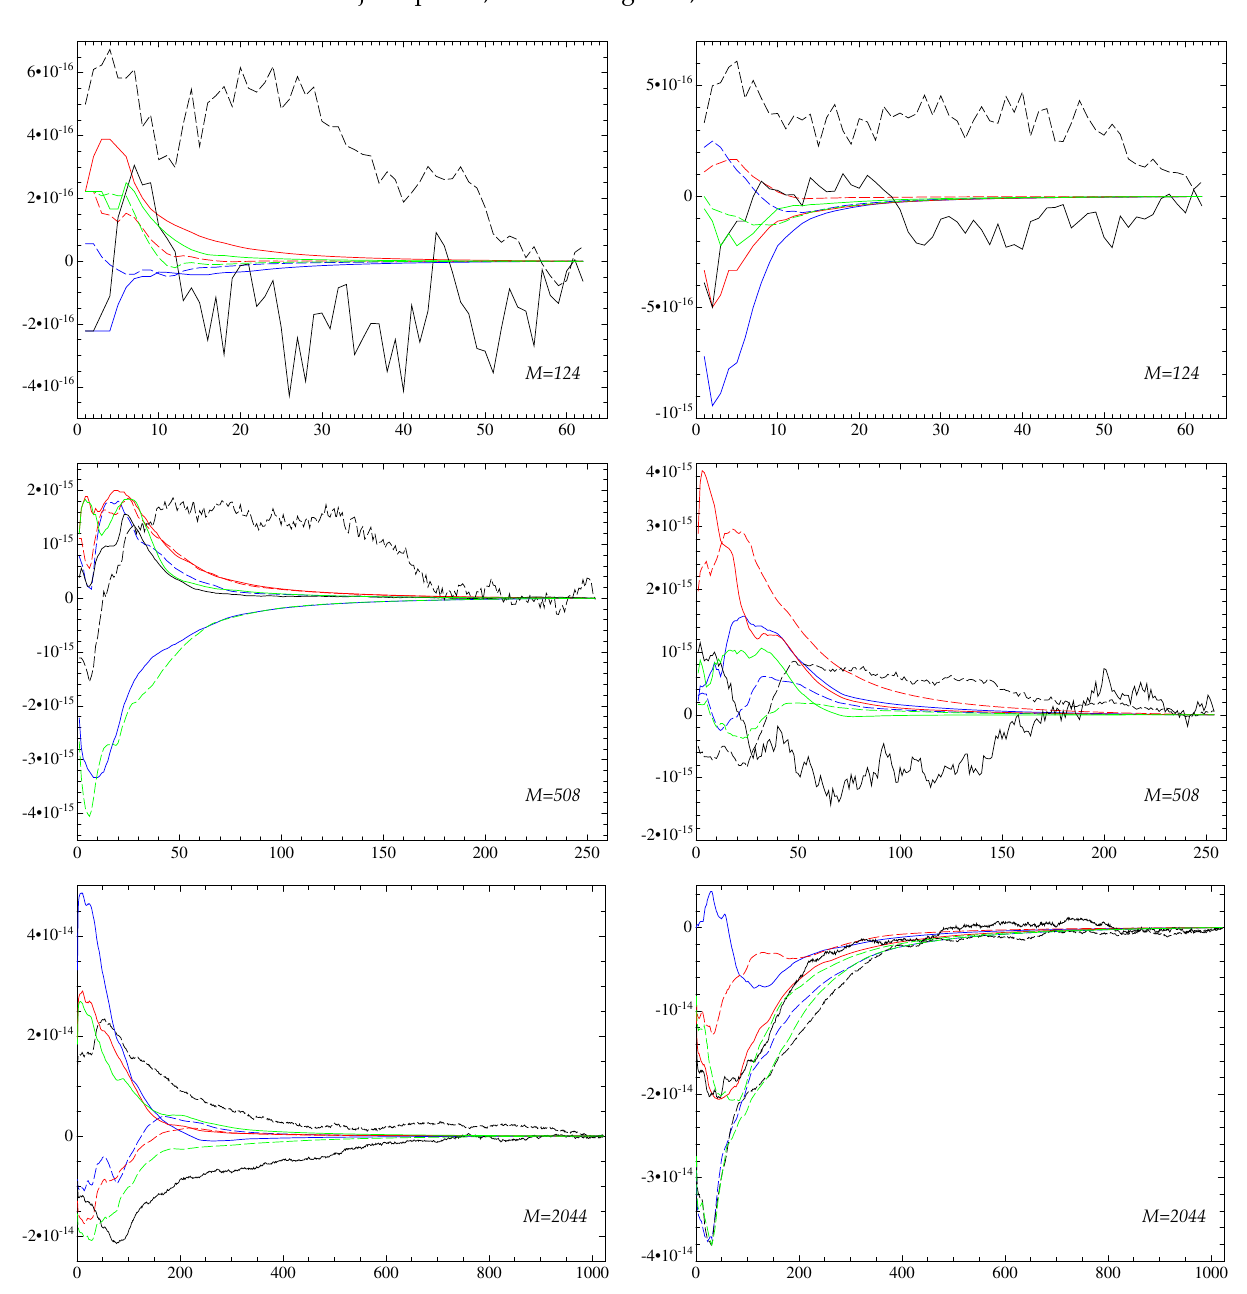
falls into the m th bin, i.e., m satisfies the inequality m − 1 < (cid:107) q ( p ; k ) (cid:107) / ω ( p ) ≤ m . For each algorithm and both error norms (the maximum norm and the energy norm), Figure 5 shows ( k ) the histogram N m versus the bin number m . The data points are joined up to the smallest ( k ) = 0, and the outlier values N ( k ) > 0 (always small) for larger m are shown m such that N m m as disjoint points; unlike in Figure 3, all outliers are shown.